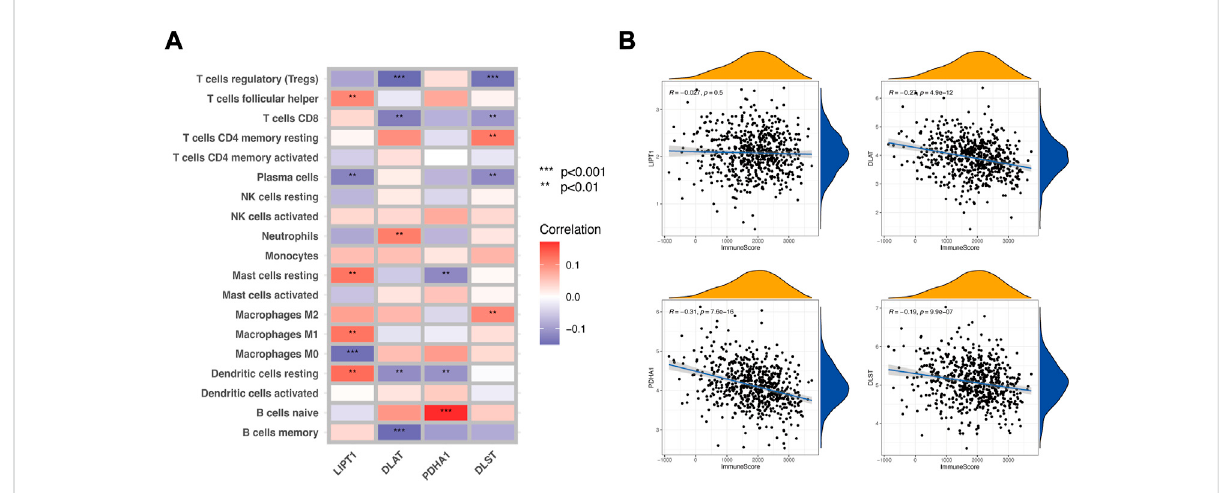
FIGURE 2 Identi fi cation of CRGs associated with LUAD immune pro fi les. (A) Correlation between the CIBERSORT data of immune cell in fi ltration and the 4 CRGs ( LIPT1 , DLAT, PDHA1, and DLST ). (B) Correlation between the ImmuneScore of ESTIMATE and the 4